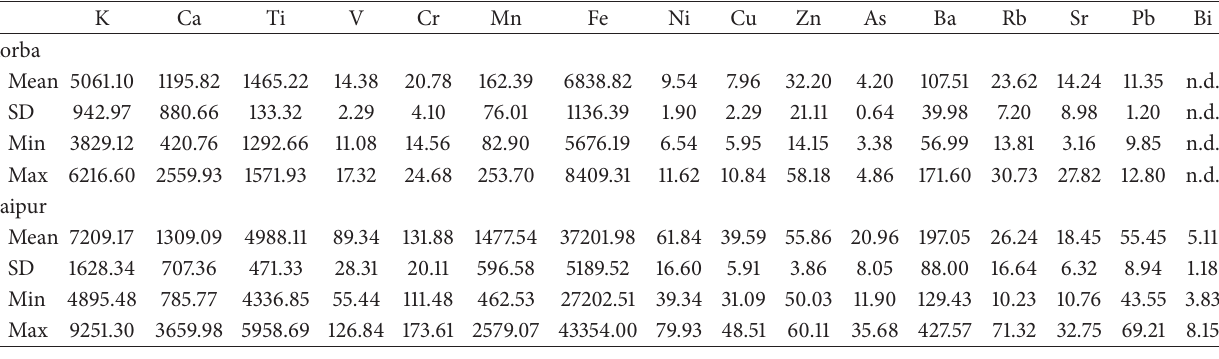
Table 3: Descriptive statistics results of elemental chemical analysis for Korba and Raipur soils.